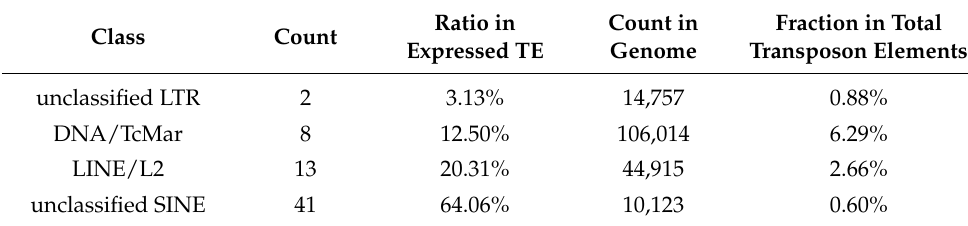
Table 2. Statistics of expressed transposable